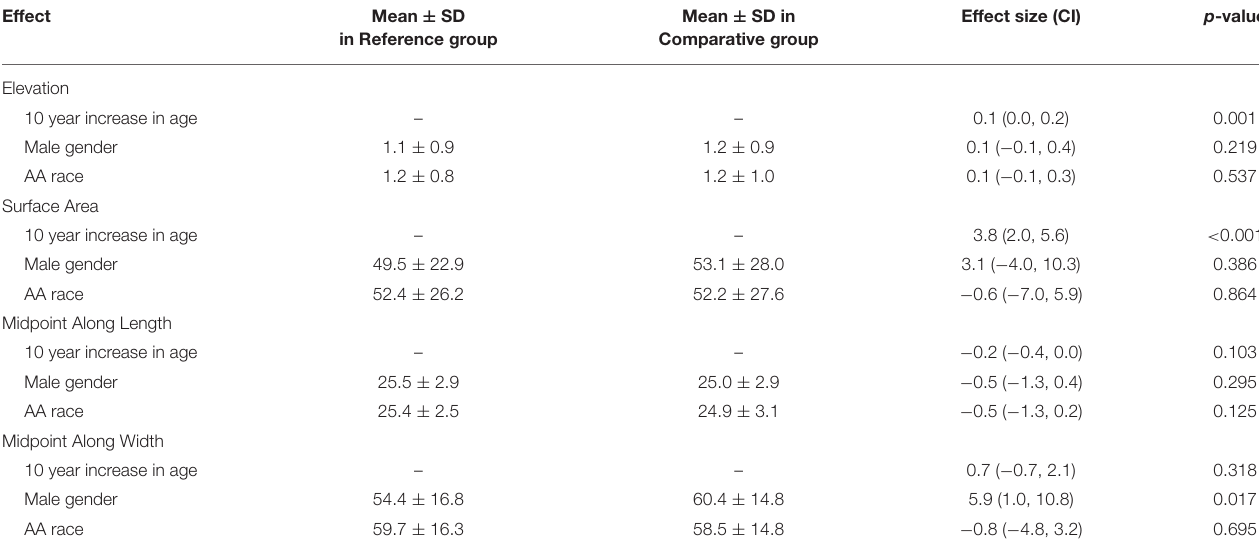
TABLE 4 | Univariate models of CCJ morphology.